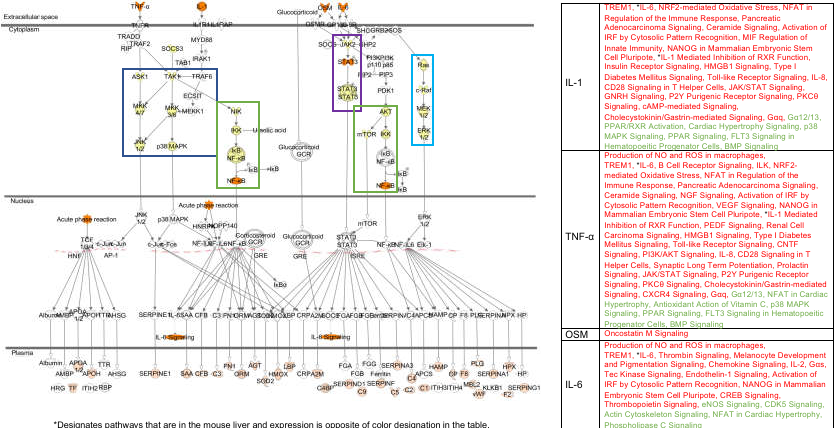
Figure 2. The acute phase response (APR) is central to the FL induced response in skin, brain, and liver of all three model organisms. Four main regulators ( IL1B , TNF , OSM, and IL-6 ) are central to this response (top of pathway in dark orange). The expression of these regulators controls four major signaling cascades, the MEK/MKK cascade (dark blue), the NFkβ cascade (green), the JAK/STAT cascade (purple), and the Ras/Raf cascade (light blue). The pathways from Tables 2–4 that overlap with the APR (designated AP in each table) all fall into one of these signaling cascades under the control of one of the four primary regulators (Table on the right). The products following the APR are highlighted in light orange and each helps induce an inflammatory and/or immune response in the organism. Pathways in the table on the right are in red font if they are up-modulated and green font if they are down-modulated. Pathways labeled by an * are in the mouse liver as well as other organs tested. The color indicated for these pathways follows the primary response and is; therefore, opposite in the mouse liver.